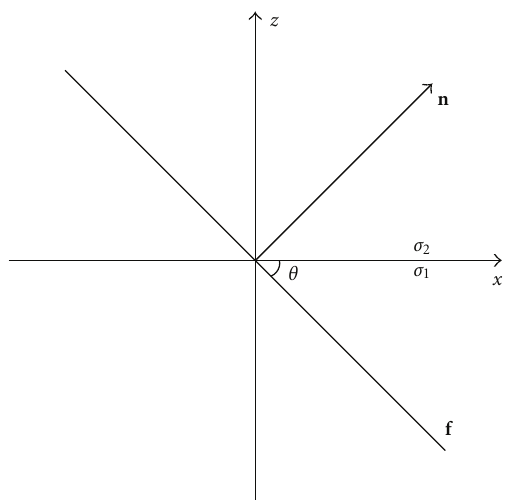
Figure 5: Seismic pulse propagates in the direction ( n ) perpendic- ular to the wave front ( f ) in the xz plane in the two-layered media with the incidence angle of θ